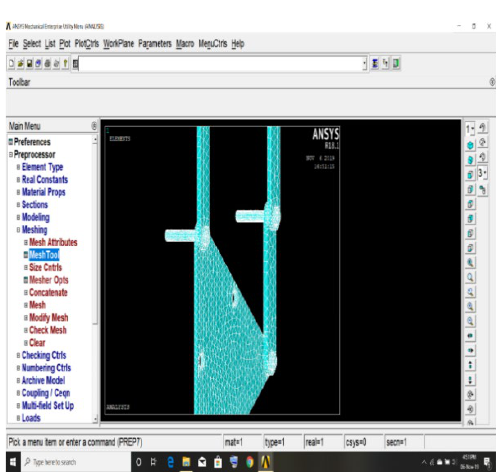
Figure 9. The stress analysis of 3RRR planar parallel